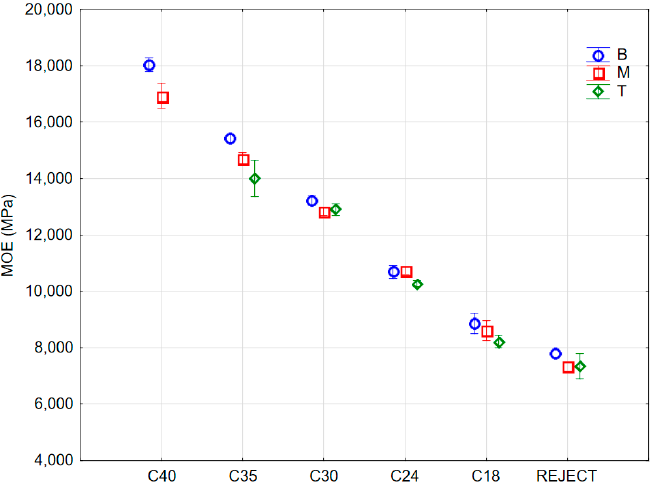
Figure 4. Modulus of elasticity distribution within timber strength classes.